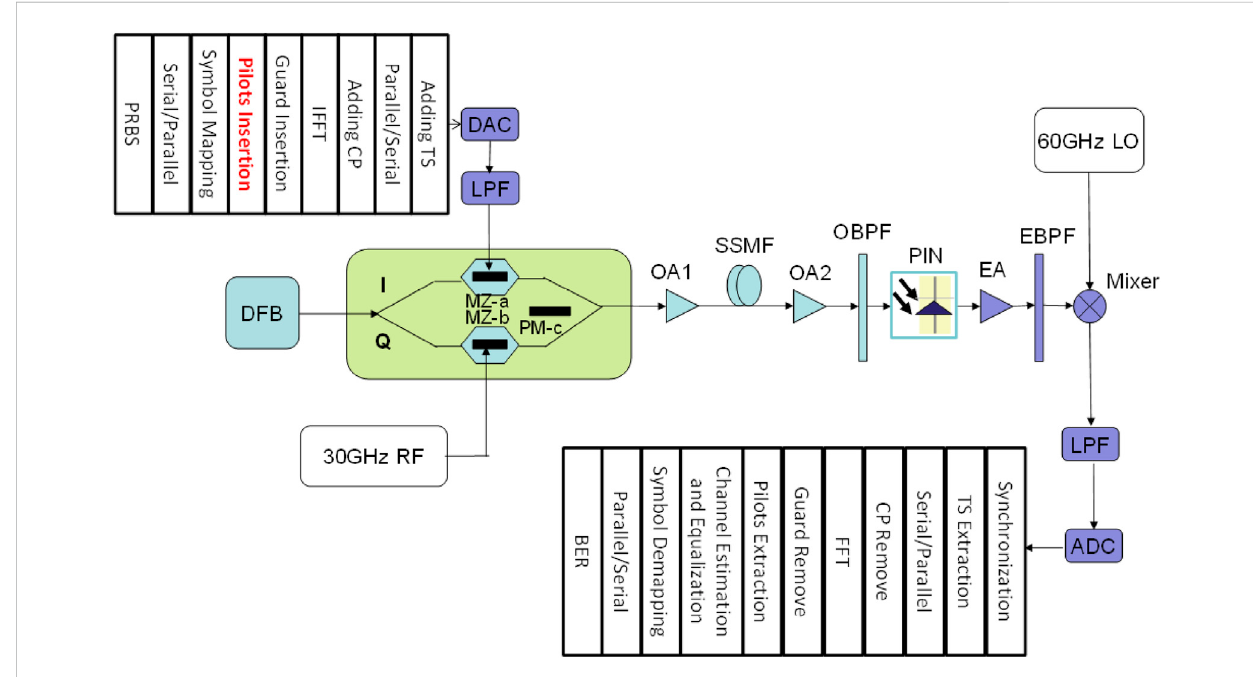
FIGURE 4 Simulation structure diagram of the RSSB-OFDM system with pilot